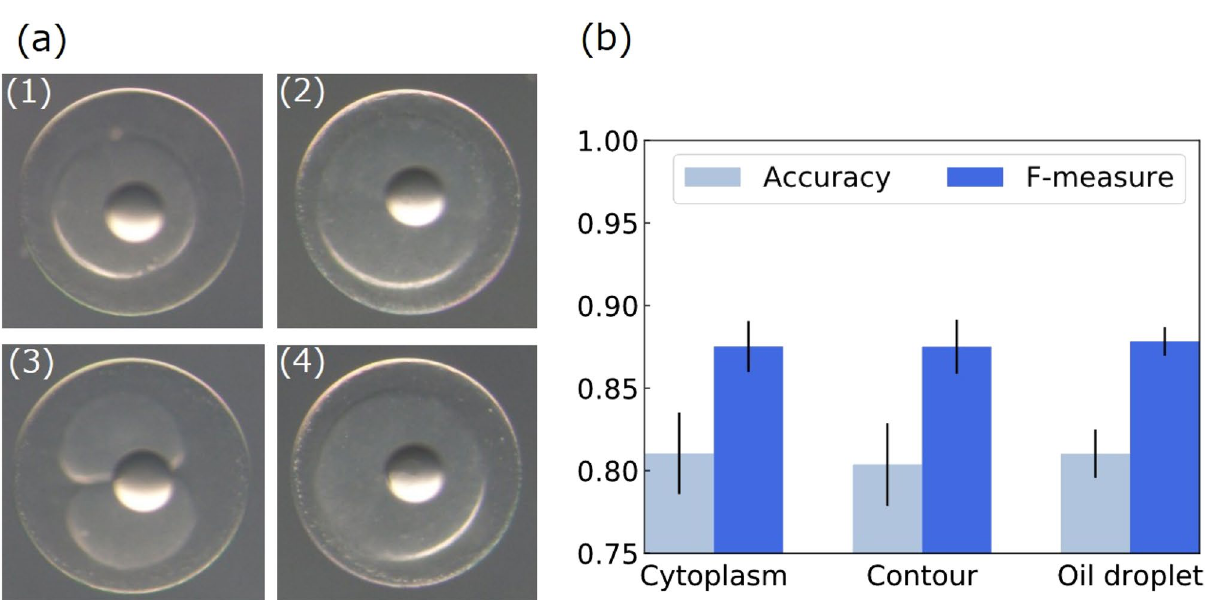
Figure 4. Result of SD prediction. ( a ) The system successfully predicted (1) and (2) but failed in (3) and (4). (1) and (4) were more than four SD; (2) and (3) were NH but within four SD. ( b ) Accuracy averages and standard errors and F-measure for SD prediction in ten-fold